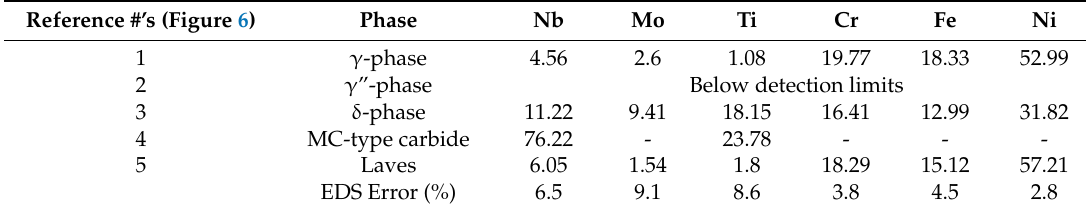
Table 1. EDS spot analysis (in at %) of phases 1–5 illustrated in Figure 6.